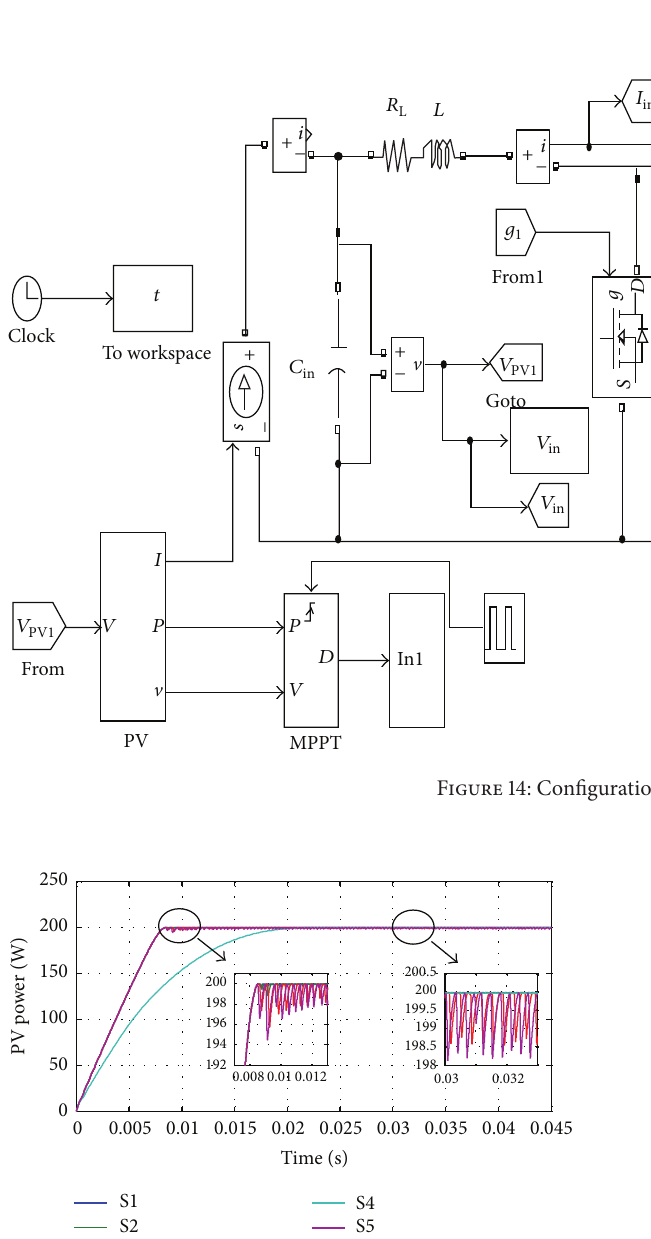
Figure 16: PV voltage at irradiation of 1000 W/m 2 and 25 ∘